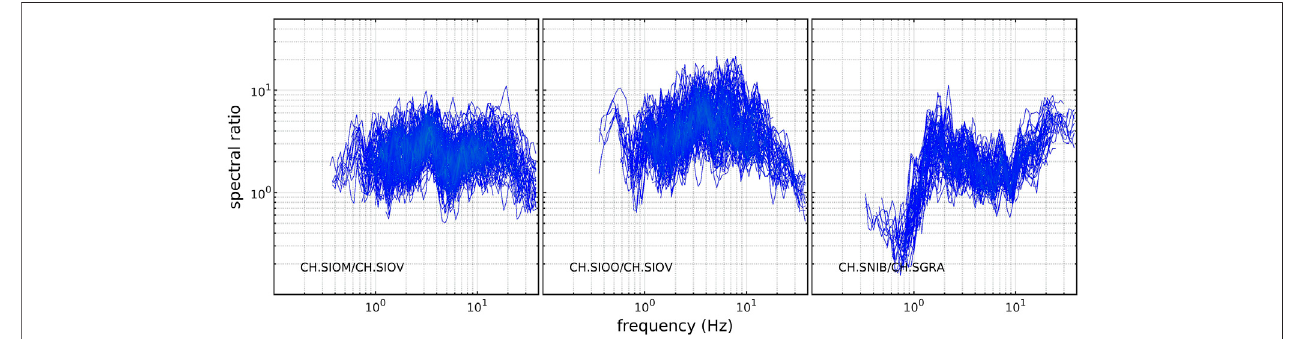
FIGURE 3 | Ampli fi cation function computed from the standard spectral ratio between 3 pairs of stations in Switzerland. The color from dark blue to light blue indicates an increasing density of curves, each curve corresponding to one single earthquake.